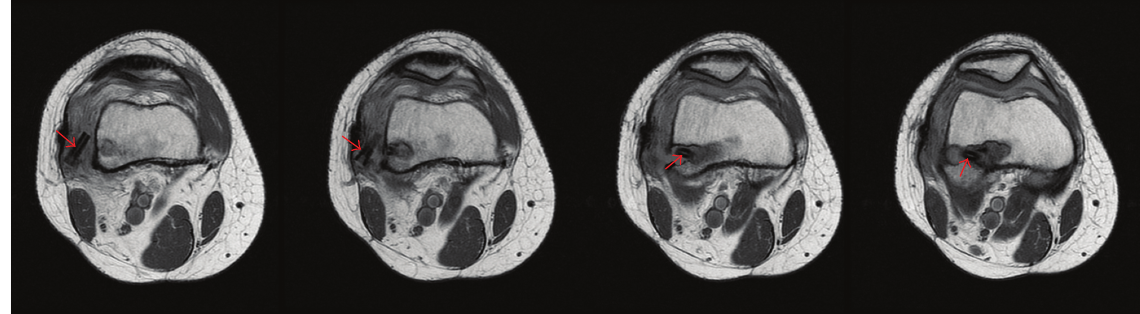
Figure 1: Axial PD fat suppressed T2-weighted images of a right knee in a patient with prior anterior cruciate reconstruction demonstrate a fractured Bio-TransFix cross pin (red arrows).